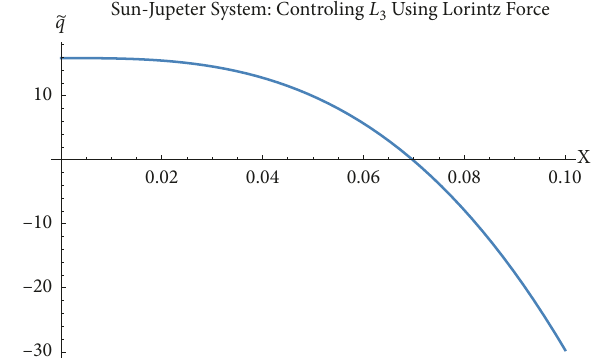
Figure 6: Specific charge to generate artificial liberation points � 0 . about L 3